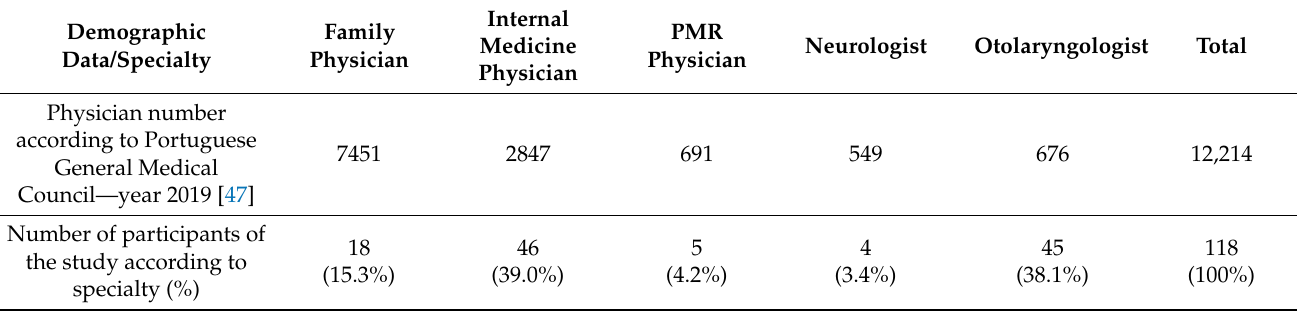
Table 1. Study quantitative: Demographic data of the participants. PMR: physical medicine and